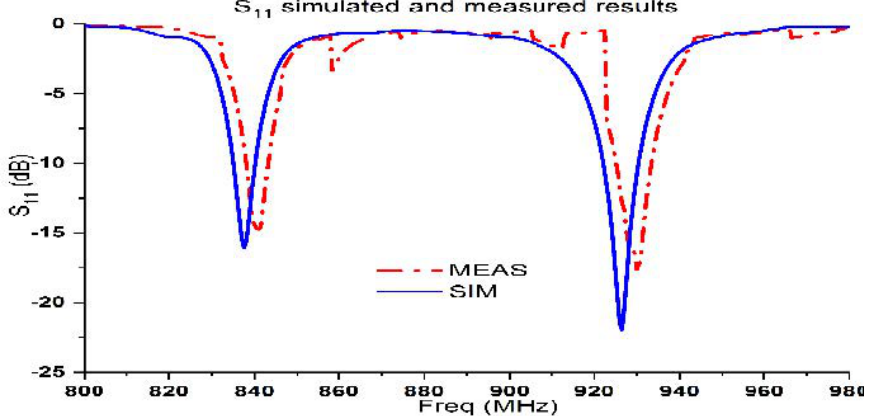
Figure 17. Reflection coefficient (S 11 ): simulations versus measurements.